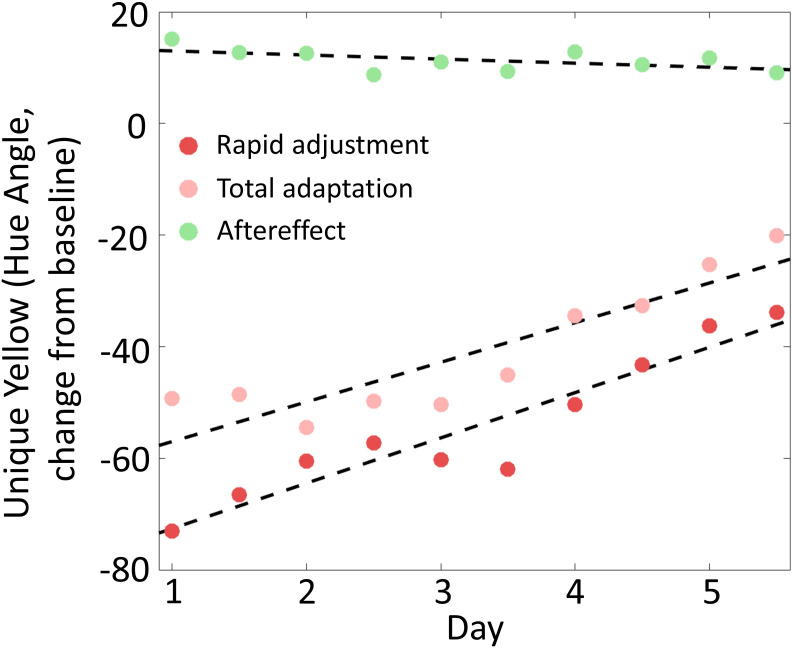
Rapid adjustment, total adaptation, and color aftereffect across 5 days.Red dots show rapid adjustments, computed as mean settings from the first 5-min test of each session with the glasses on. Total adaptation effects, denoted by the pink dots, are mean settings from the test taken after 1hr of wearing the glasses. Green dots are mean settings of the first 5-min test after removing the glasses. Data have been corrected for possible baseline shifts by subtracting the baseline value for each morning session, taken immediately before putting the glasses on. The black dashed lines are linear fits to the rapid adjustment, total adaptation, and the aftereffect. Both rapid adjustment and total adaptation effect grew significantly over days, and there was a trend for aftereffects to decrease across day.Figure 3—source data 1.Figure 3 data.